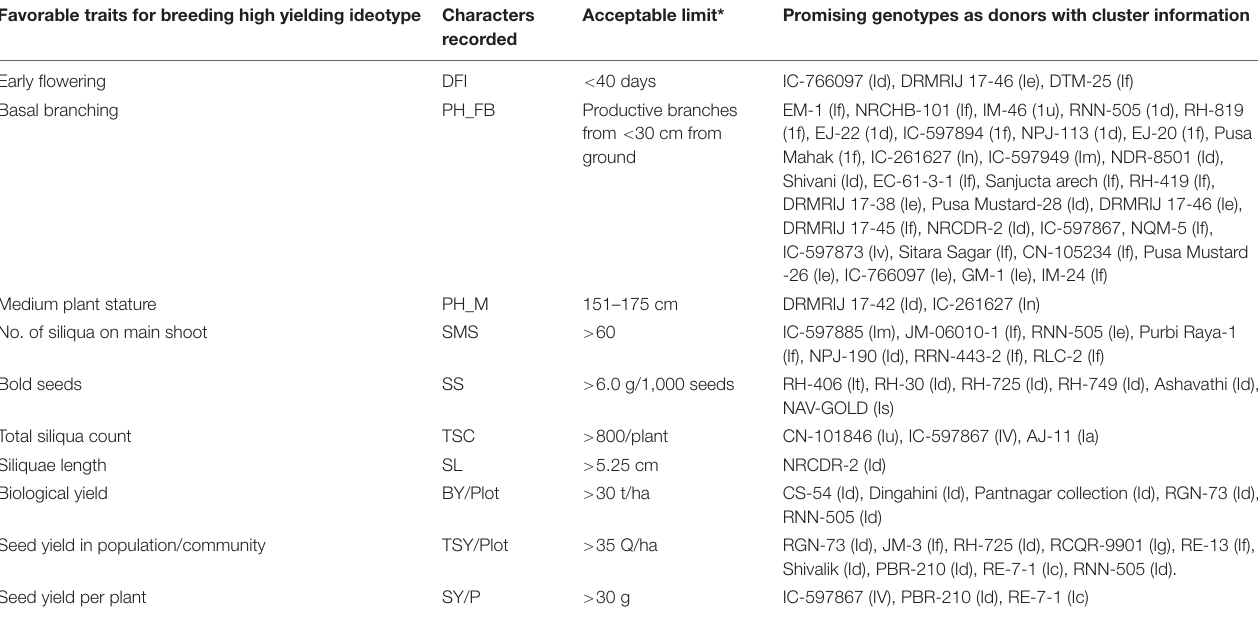
TABLE 5 | Promising genotypes and traits identified under study.